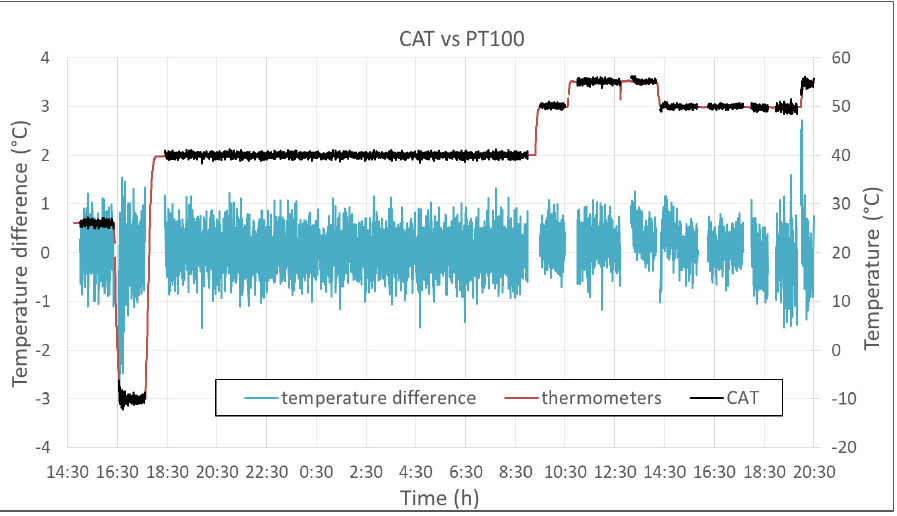
Figure 6. Typical measurement series. The red curve is the average of the temperatures measured by the three reference thermometers and considered as the reference temperature of the chamber ( right scale ). The temperature was set, respectively, to 26, − 10, 40, 50, 55, 50, and 55 °C. In black: the temperature estimated from the speed of sound. The blue curve is the difference between the two curves ( left scale ). The interruptions in the data sets that can be observed at 55 and 50 °C refer to when the relative humidity set point was changed and the system was stabilizing to the new level.